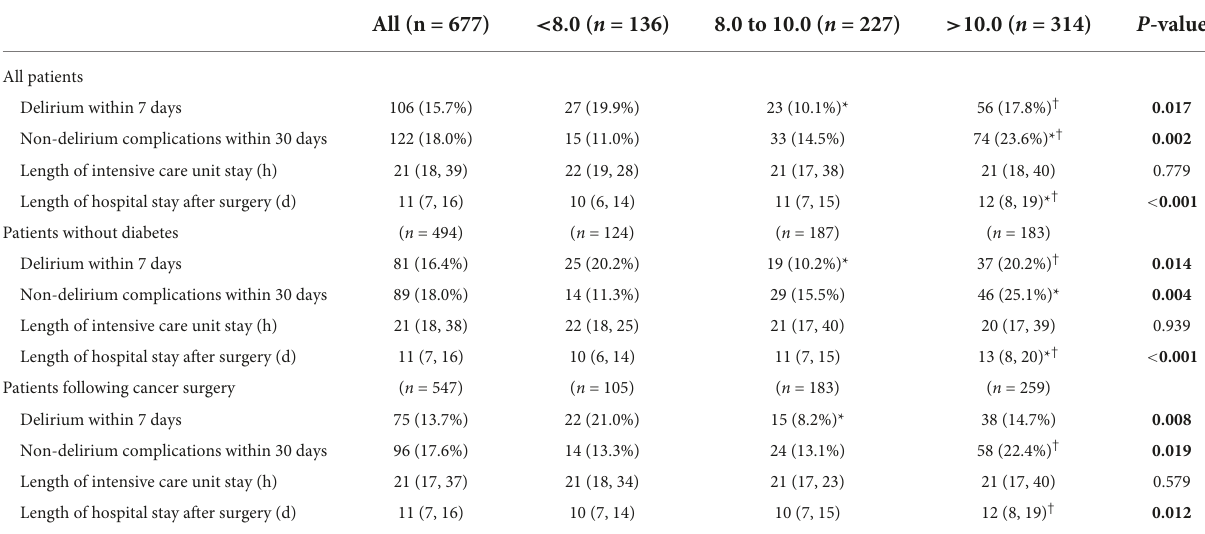
TABLE 4 Postoperative outcomes within 30